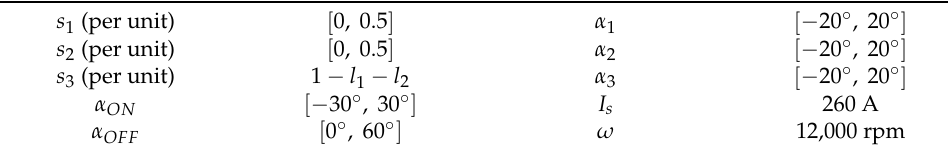
Table 5. Variables to optimize and their operation